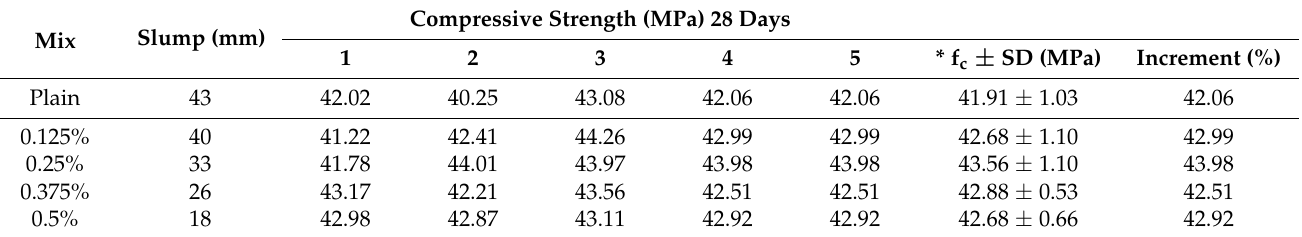
Table 4. The result of the compression and slump test.